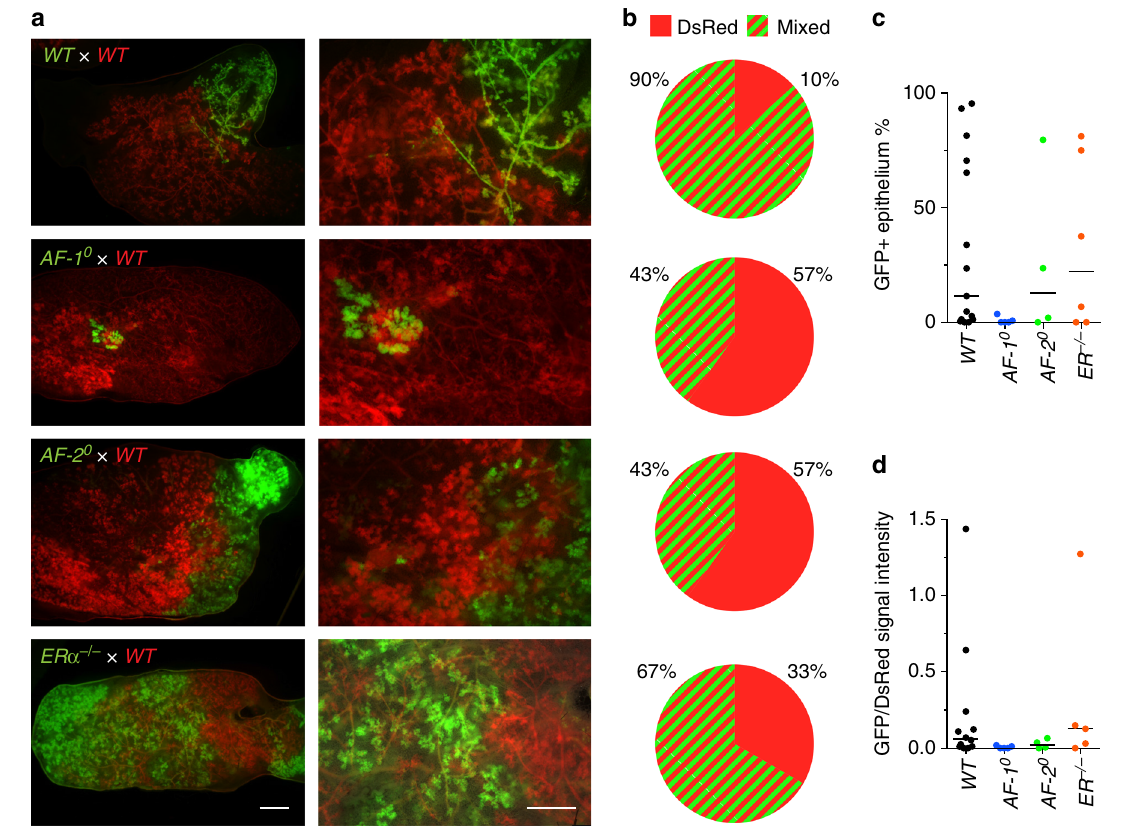
Fig. 5 Proliferation of AF-1 0 , AF-2 0 and ER α − / − cells in chimeric epithelia during pregnancy. a Representative fl uorescence stereomicrographs of chimeric epithelia from WT.GFP + or ER α mutant.GFP + and WT.DsRed + cells mixed in a 1:10 ratio. Hosts were analysed at P16 – 18. Scale bars; 1 mm. b Pie charts showing the number of mammary glands presenting only DsRed + epithelial regenerations (red) or mixed + and GFP + regenerations (red and green stripes) based on evaluation on “ low magni fi cation 7.8× ” fl uorescence stereomicrographs; from top to bottom, n = 20, 7, 7 and 6. c Dot plot showing percentage of area fi lled with GFP + structures over total area fi lled in chimeric glands during pregnancy; evaluation at 7.8× magni fi cation; shown are means ± SEM. d Dot plot showing ratios of GFP over DsRed signal intensity of different chimeras in pregnant hosts ( n = 4 – 16; black line: